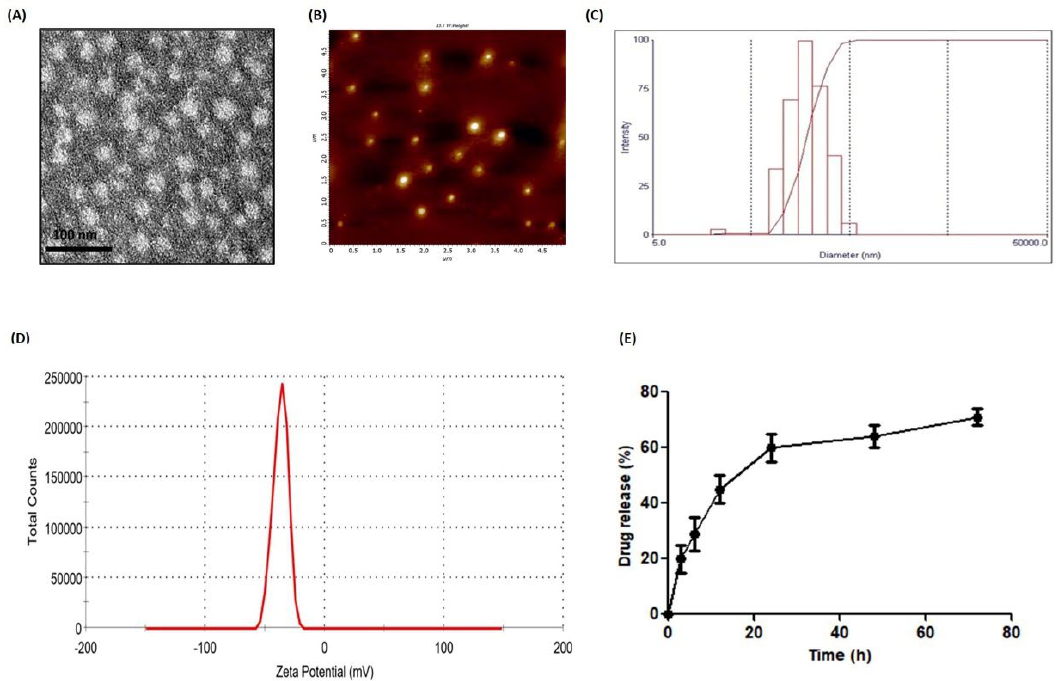
Figure 1. Characterization and drug release profile of PLGA-Dtx nanoparticles. ( A ) TEM image; ( B ) AFM image; ( C ) mean particle size distribution; ( D ) zeta potential; ( E ) in vitro release profile of PLGA-Dtx NPs.